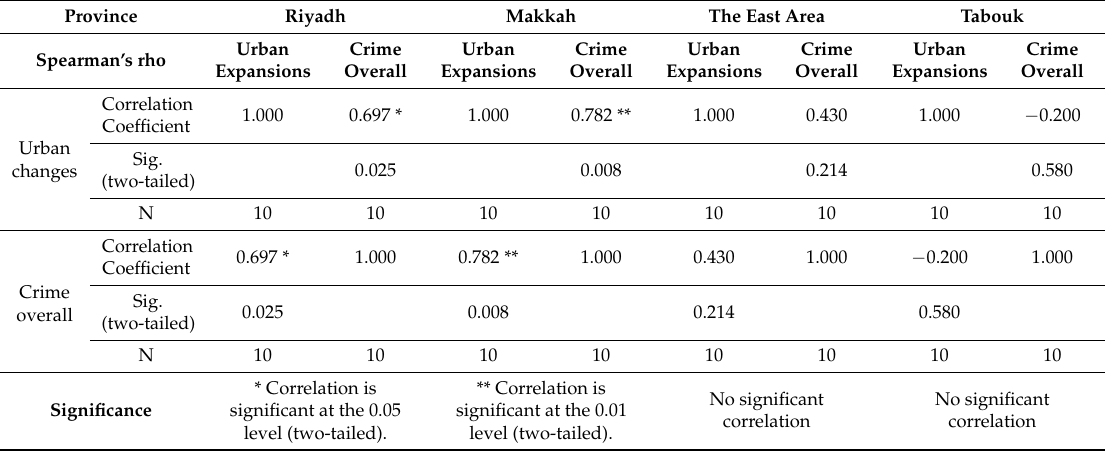
Table 4. Spearman’s rank-order correlation test